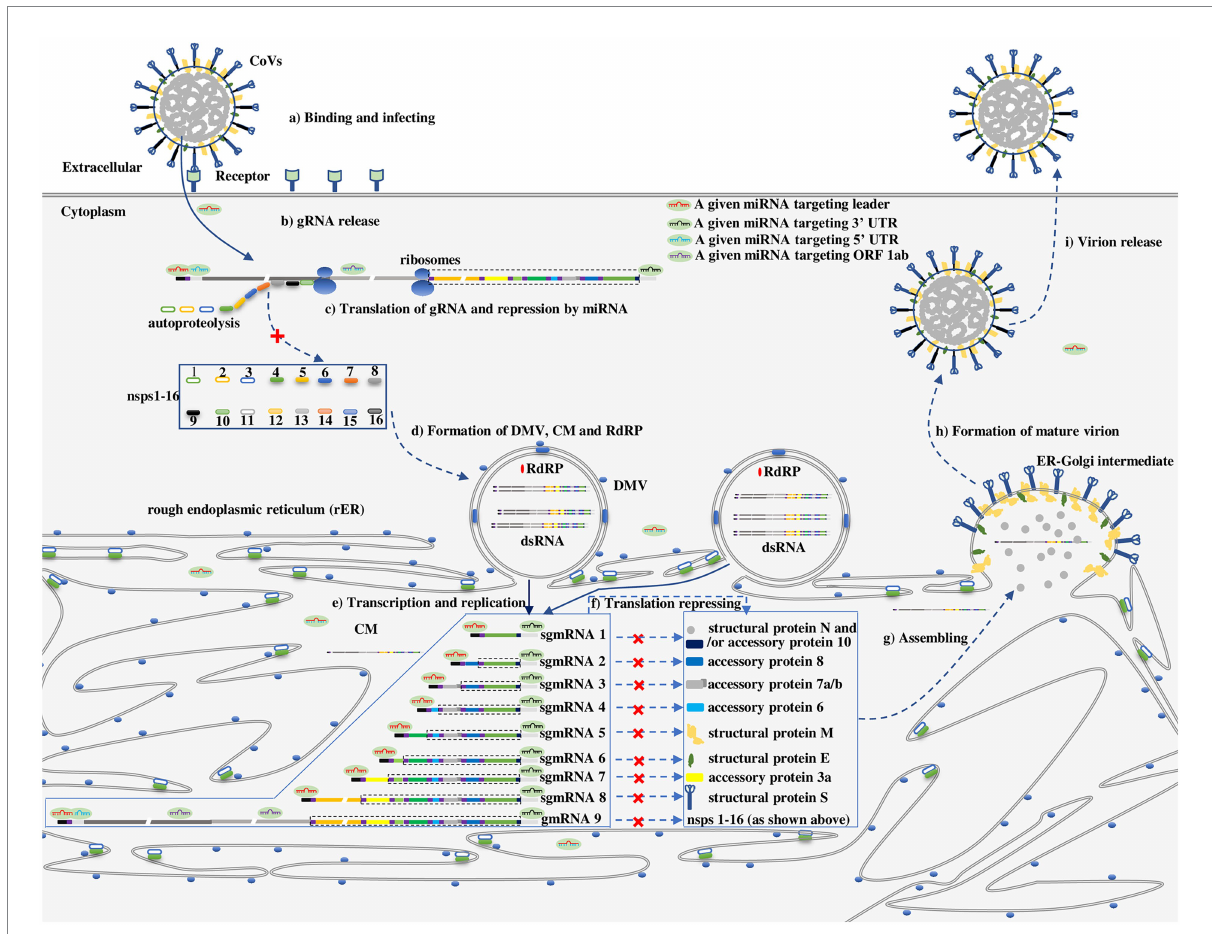
FIGURE 2 The proposed repressive effect of a series of given miRNAs on HCoVs in different subcellular compartments along with the viral life cycle (Hartenian et al., 2020). (a) Binding and infecting: CoVs bind to a cell receptor and invade cells via either cytomembrane fusion or endocytosis. (b) gRNA release: gRNA is released and uncoated, enabling its recognition by ribosomes. (c) Translation of gRNA and repression by miRNAs in unremodeled cytosol: Upon release of gRNA, nsps1-16 are translated from ORF 1a/b in gRNA, however, the process can be repressed by a miRNA targeting a leader, ORF 1a/b, 3’ UTR. (d) Formation of double-membrane vesicles (DMVs), convoluted membranes (CMs) and RdRPs: RdRPs, DMVs and CMs are assembled or established by nsps1-16. (e) Transcription and replication: Replication and transcription of gRNA in DMVs to generate a nested set of subgenomic mRNAs (sgmRNAs) or gmRNAs. (f) Translation of the nested set of HCoVs mRNA and repression by miRNAs on CMs or in CMs-protected cytosol: The nested set of mRNAs is translated into corresponding proteins on CMs or in CMs-protected cytosol. However, the translation of mRNA can be repressed by a miRNA targeting a leader, ORF 1a/b, or 3’ UTR. (g) Structural proteins and gRNA assembly in the ER- Golgi intermediate leading to (h) formation of mature virions (i) that are released from a cell. As in Figure 1c, the untranslated sequences or ORFs in the sgmRNA are indicated by dotted